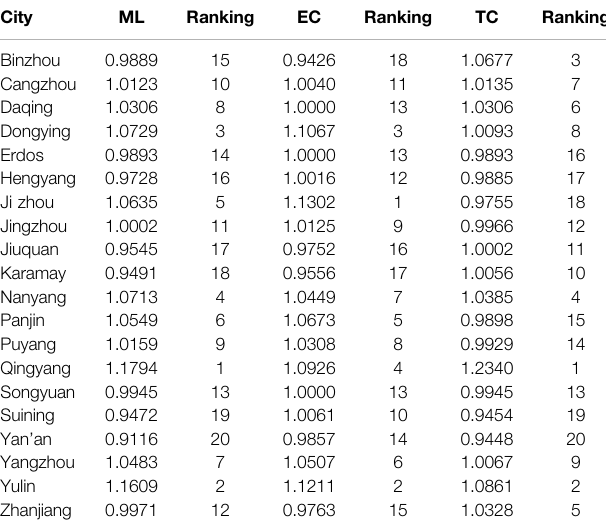
TABLE 6 | Decomposition results of green total factor growth ef fi ciency of Oil and gas resource-based cities.